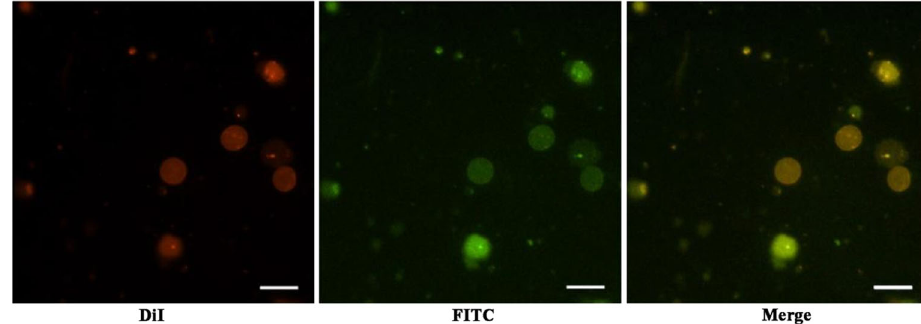
Fig. 3 The fl uorescence microscope image of DSPE-PEG-FITC modi fi ed and DiI labeled RBC membrane. (Scale bar: 10 μ m)